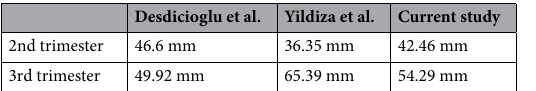
Table 4. Comparison of PM tendon length as a function of trimester of